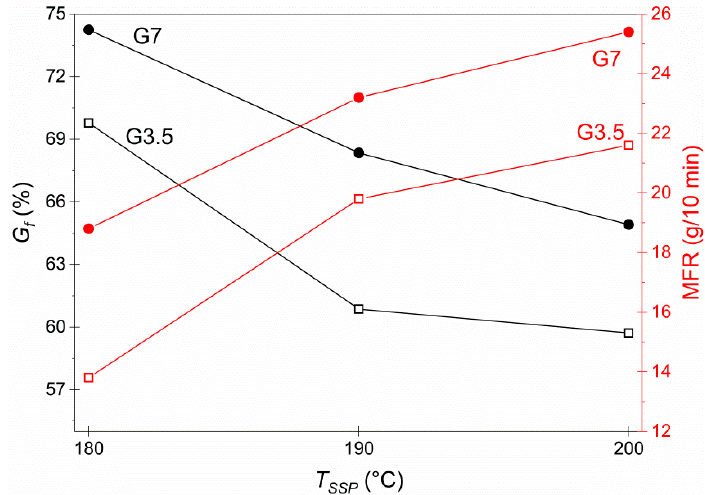
Figure 2. Highest crosslinking extent ( G f ) and highest melt strength (MFR) of the produced vitrimers G3.5 and G7 as a function of solid-state polymerization (SSP) temperature (180 °C, 190 °C and 200 °C) after 3 h of reaction.